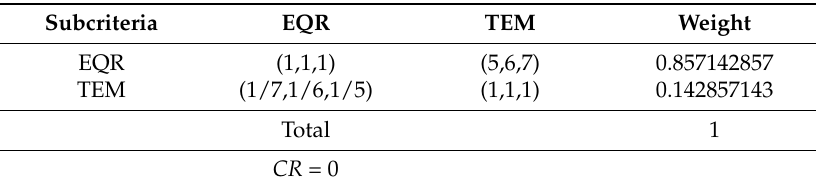
Table A16. Comparison matrix for IEE.